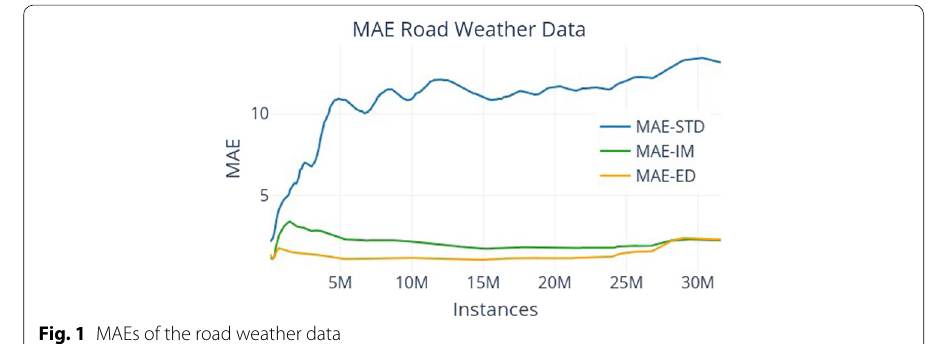
Fig. 1 MAEs of the road weather data